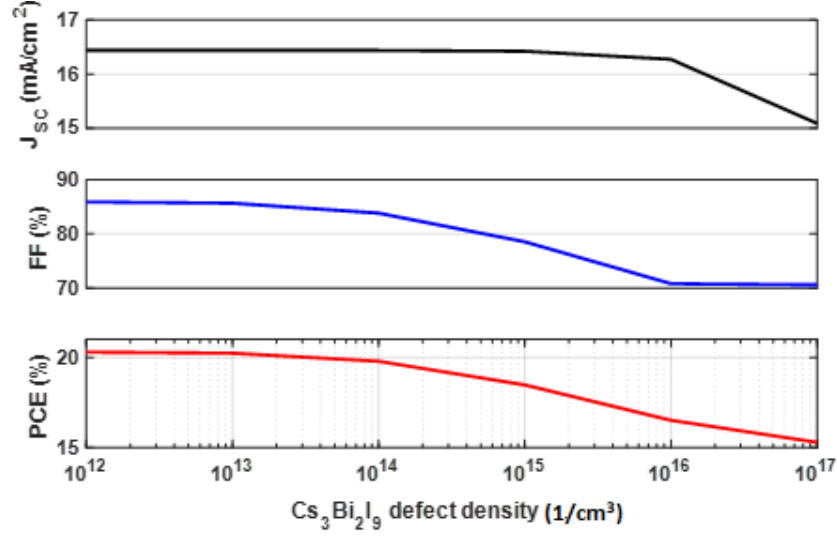
Figure 5. Effect of Cs 3 Bi 2 I 9 defect density on the performance parameters.